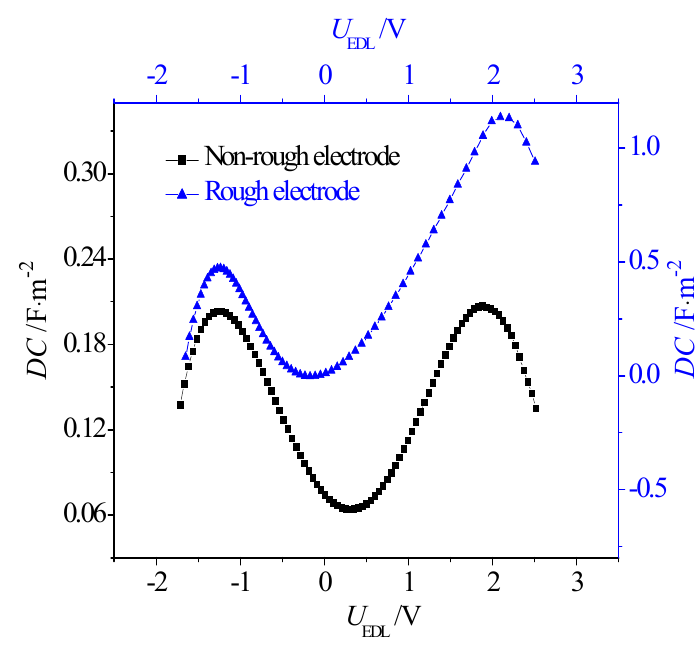
Figure 9. Correlation between the capacitance and the potential drop across the EDLs on the rough and non-rough